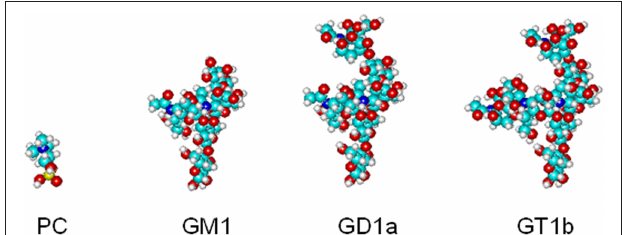
Figure 1 | Schematic representation of the volume occupied by phosphocholine, the headgroup of phosphatidylcholine (PC), and by the oligosaccharide chains of three gangliosides of the ganglio tetraose serie, monosialoganglioside gM1, disialoganlioside gD1a, trisialoganglioside